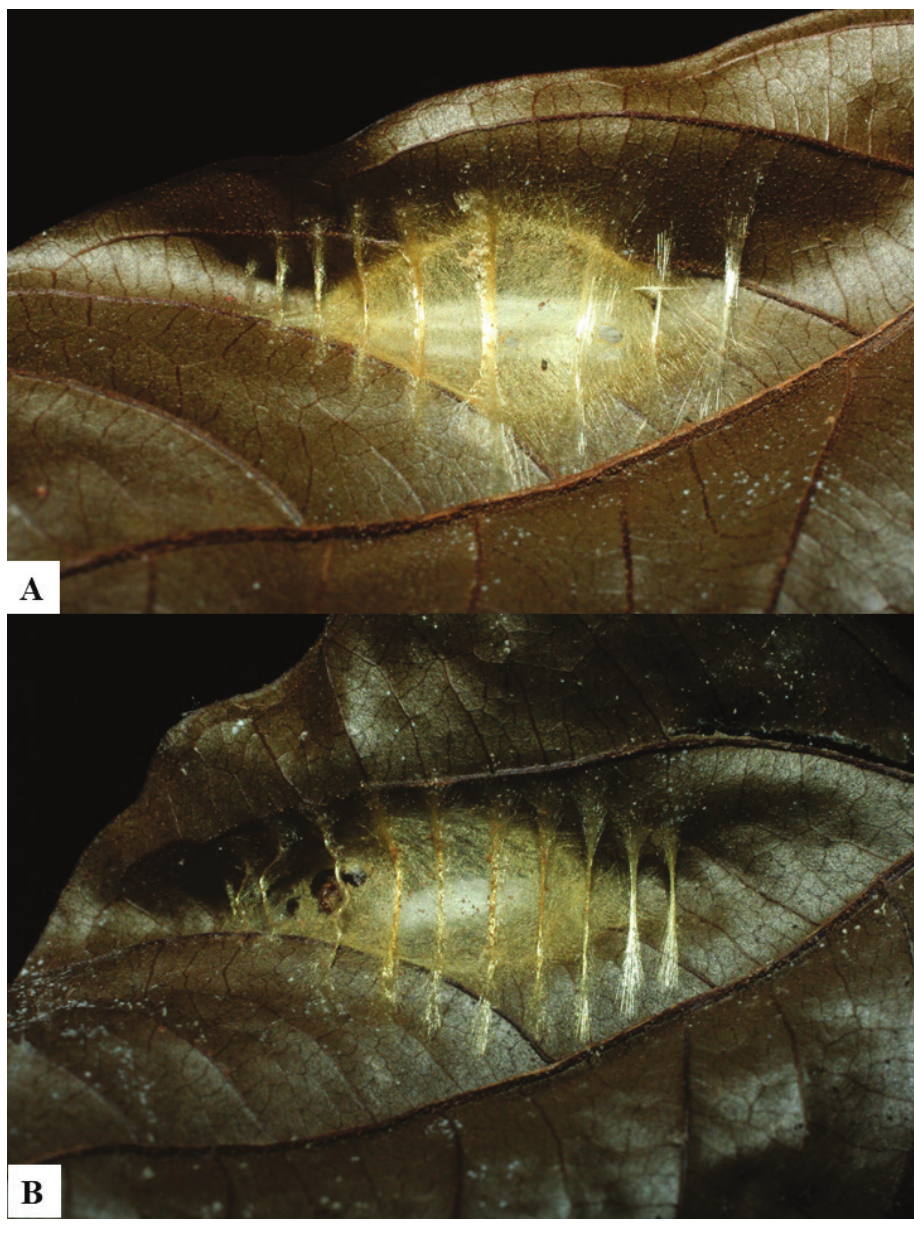
Figure 11. A, B Cocoons of Dolichogenidea angelagonzalezae sp.